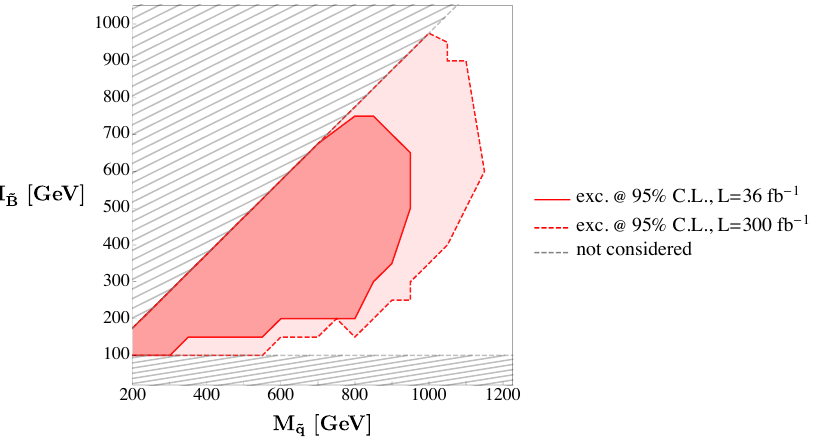
Figure 4. Current and forecasted 95% exclusion limits from searches for jets+ =E the squark mass ( M ~ q ) | bi (cid:23) o mass ( M ~